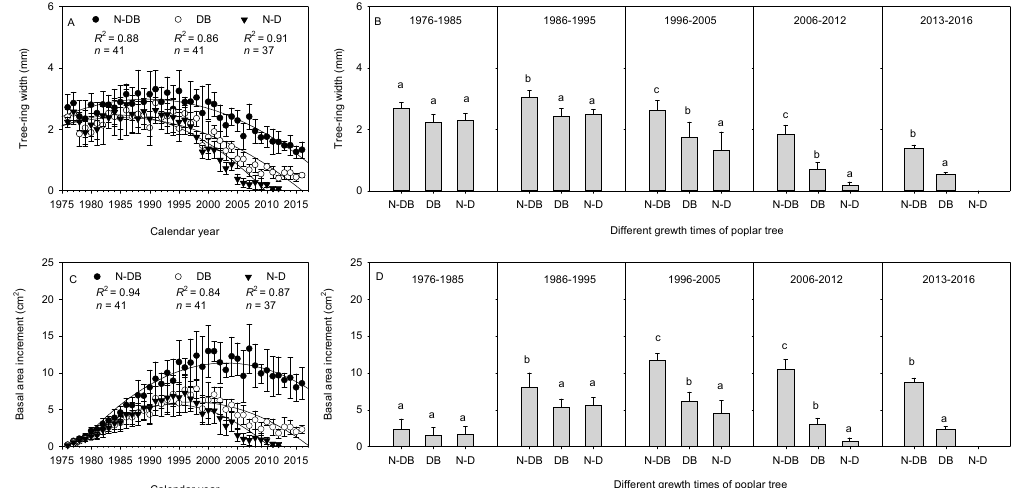
Figure 5. Differences in tree-ring width ( A , B ) and basal area increment ( C , D ) among now-dead (N-D), dieback (DB) and non-dieback (N-DB) poplar trees at different growth times. Lower case letters indicate significant differences ( p < 0.05).